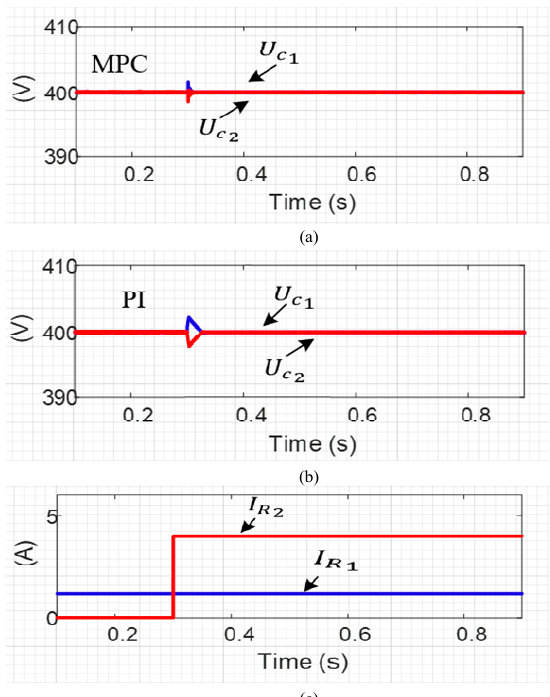
Figure 20. Experimental results. ( a ) Transient load response with MPC. ( b ) Transient load response with PI. ( c ) When load I R 2 is increasing.